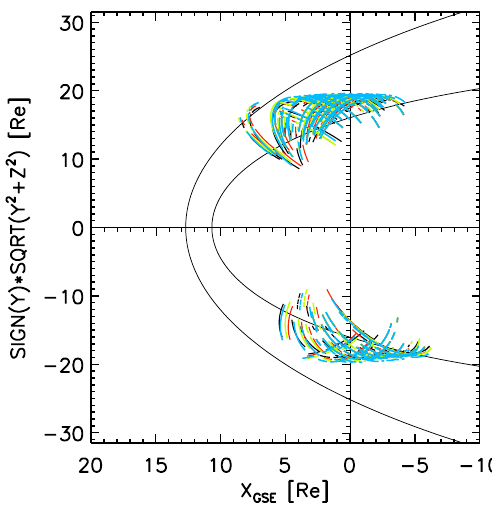
Fig. 1. Radial projections of four Cluster spacecraft orbits. The data used are from the intervals of May–June, 2002, 2003 and from November and December, 2002, 2003. The full lines display av- erage locations of both magnetopause and bow shock determined from the Petrinec and Russell (1996) and Jeˇr´ab et al. (2005) mod- els,